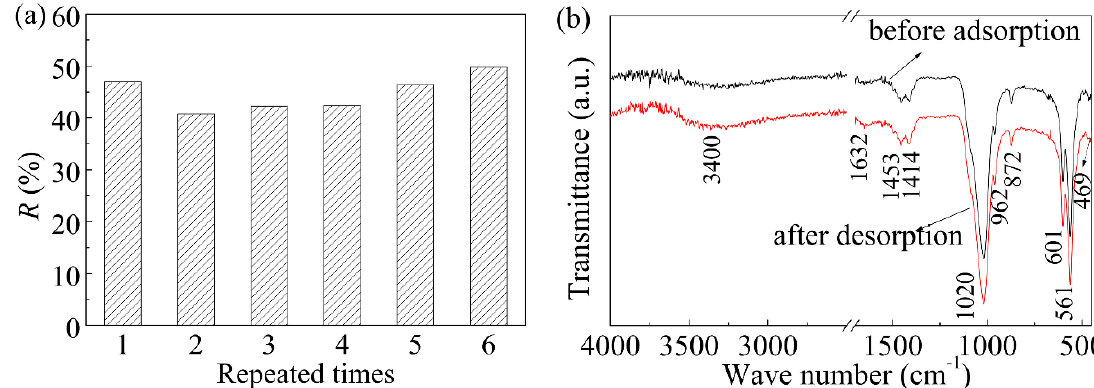
Figure 4. ( a ) The reusability result of bone char for the removal of methylene blue, ( b ) FT-IR spectra of poorly crystalline bone char sample (before adsorption and after desorption of methylene blue).